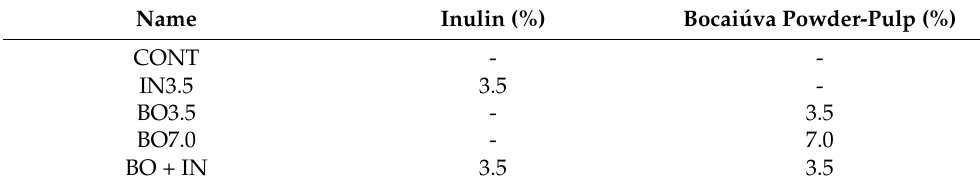
Table 1. Treatment of kefir-fermented